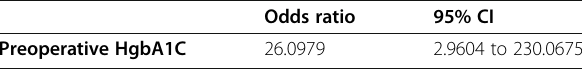
Table 6 Logistic regression for AKI and preoperative Hgb A1C AKI in relation to Hgb A1c